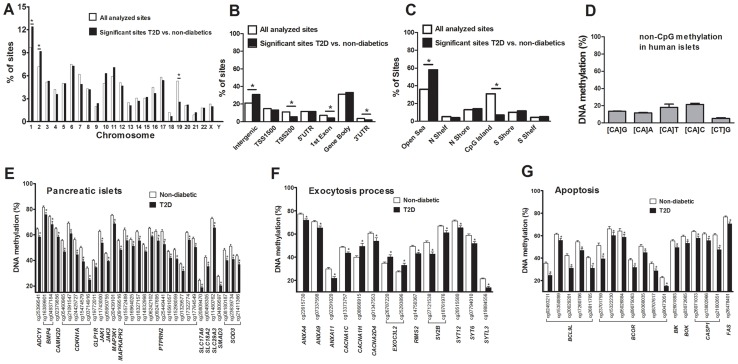
Distribution of individual sites that exhibit differential DNA methylation in human islets from 15 T2D versus 34 non-diabetic donors.(A) The chromosomal location of the 1,649 sites that exhibit differential DNA methylation in islets of T2D versus non-diabetic donors in comparison to all analyzed sites on the Infinium HumanMethylation450 BeadChip. (B) Distribution of significant CpG sites in relation to nearest gene regions. (C) Distribution of significant CpG sites in relation to CpG island regions. *The distribution of the significant sites compared with all analyzed sites on the Infinium HumanMethylation450 BeadChip is significantly different from what is expected by chance based on Chi2 tests. P-values have been corrected for multiple testing using Bonferroni correction. (D) The average degree of DNA methylation of analyzed non-CpG sites in human pancreatic islets. Genes with previous known function in (E) pancreatic islets, (F) the exocytotic process and (G) apoptosis that exhibit differential DNA methylation in T2D versus non-diabetic human islets with an absolute difference in methylation ≥5%. * q<0.05. Data are mean ± SEM.